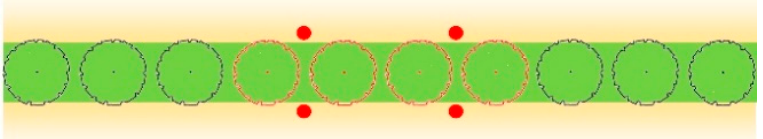
Figure 3. Arrangement of sampling locations within a representative treatment block. Trees outlined in red were sampled (visual searches for pests and natural enemies, pollinator visitation and seed counts), while the outer three trees (outlined in black) were unsampled buffer areas. The red dots represent sample locations within the adjacent arable alley (pitfall traps and sticky traps). The distance between each tree was 3 m.